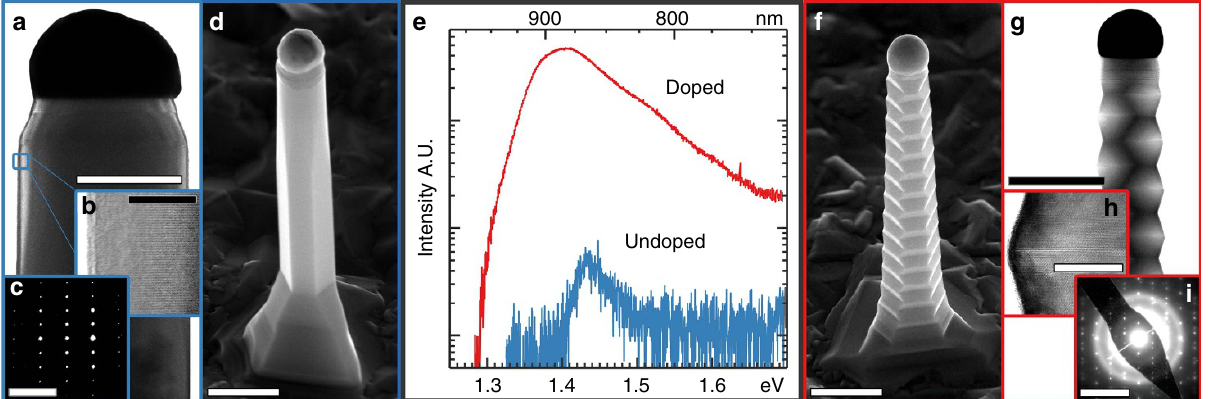
Figure 1 | Structure, morphology and photoluminescence (PL) of undoped and doped GaAs NWs. ( a ) Bright-field TEM image of an undoped GaAs NW. Scale bar, 200nm. ( b ) HRTEM image of the same undoped GaAs NW demonstrating the absence of stacking faults. Scale bar, 20nm. ( c ) Electron diffraction pattern of an undoped GaAs NWcorresponding to a pure wurtzite structure. Scale bar, 5nm (cid:3) 1 . ( d ) SEM image of an undoped GaAs NW. Scale bar, 500nm. ( e ) PL spectra collected from single undoped and doped GaAs NWs under identical excitation and collection conditions. Emission from the doped NW is seen to be orders of magnitude brighter. ( f ) SEM image of a doped GaAs NW. Scale bar, 500nm. ( g ) Bright-field TEM image of a doped GaAs NW. Scale bar, 400nm. ( h ) HRTEM TEM image of a doped GaAs NWshowing a single twin plane. Scale bar, 20nm. ( i ) Electron diffraction pattern of a doped GaAs NWcorresponding to a twinned zincblende structure. Scale bar, 10nm (cid:3) 1 . All TEM images and diffraction patterns were collected from the h 11 (cid:2) 20 i / h 110 i